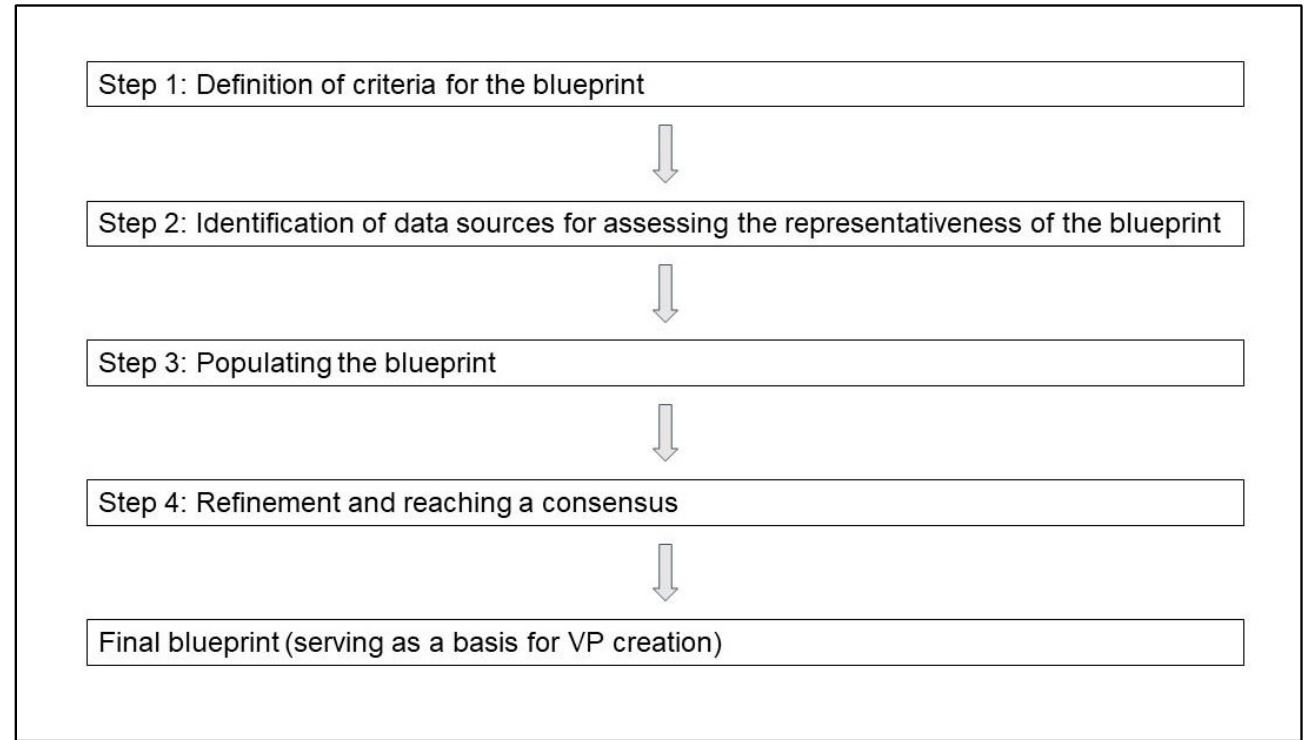
Figure 1. Flowchart of our four-step approach to create the blueprint. (VP = Virtual patient). Step 1: Definition of criteria for the blueprint